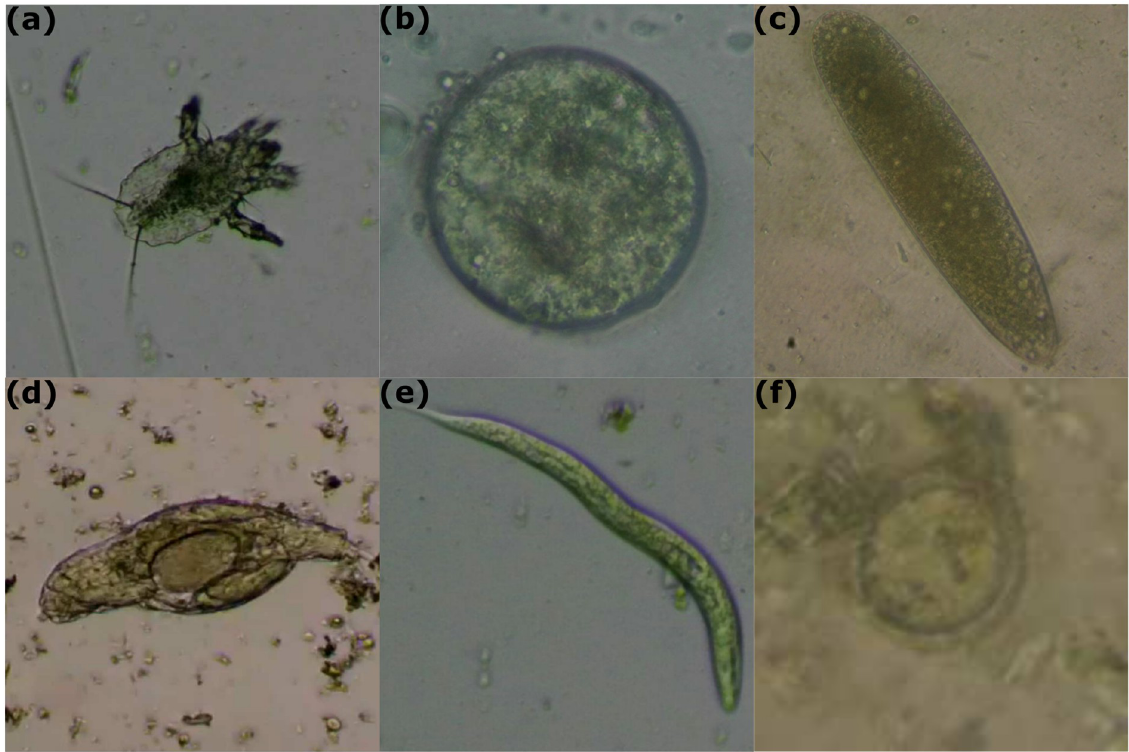
Fig 2. Examples of each parasite. (a) Acaro ( Ophionyssus natricis ); (b) Blastocystis sp ; (c) Oxiurdo egg ; (d) Rhytidoides similis ; (e) Strongyloides ; (f) Taenia .